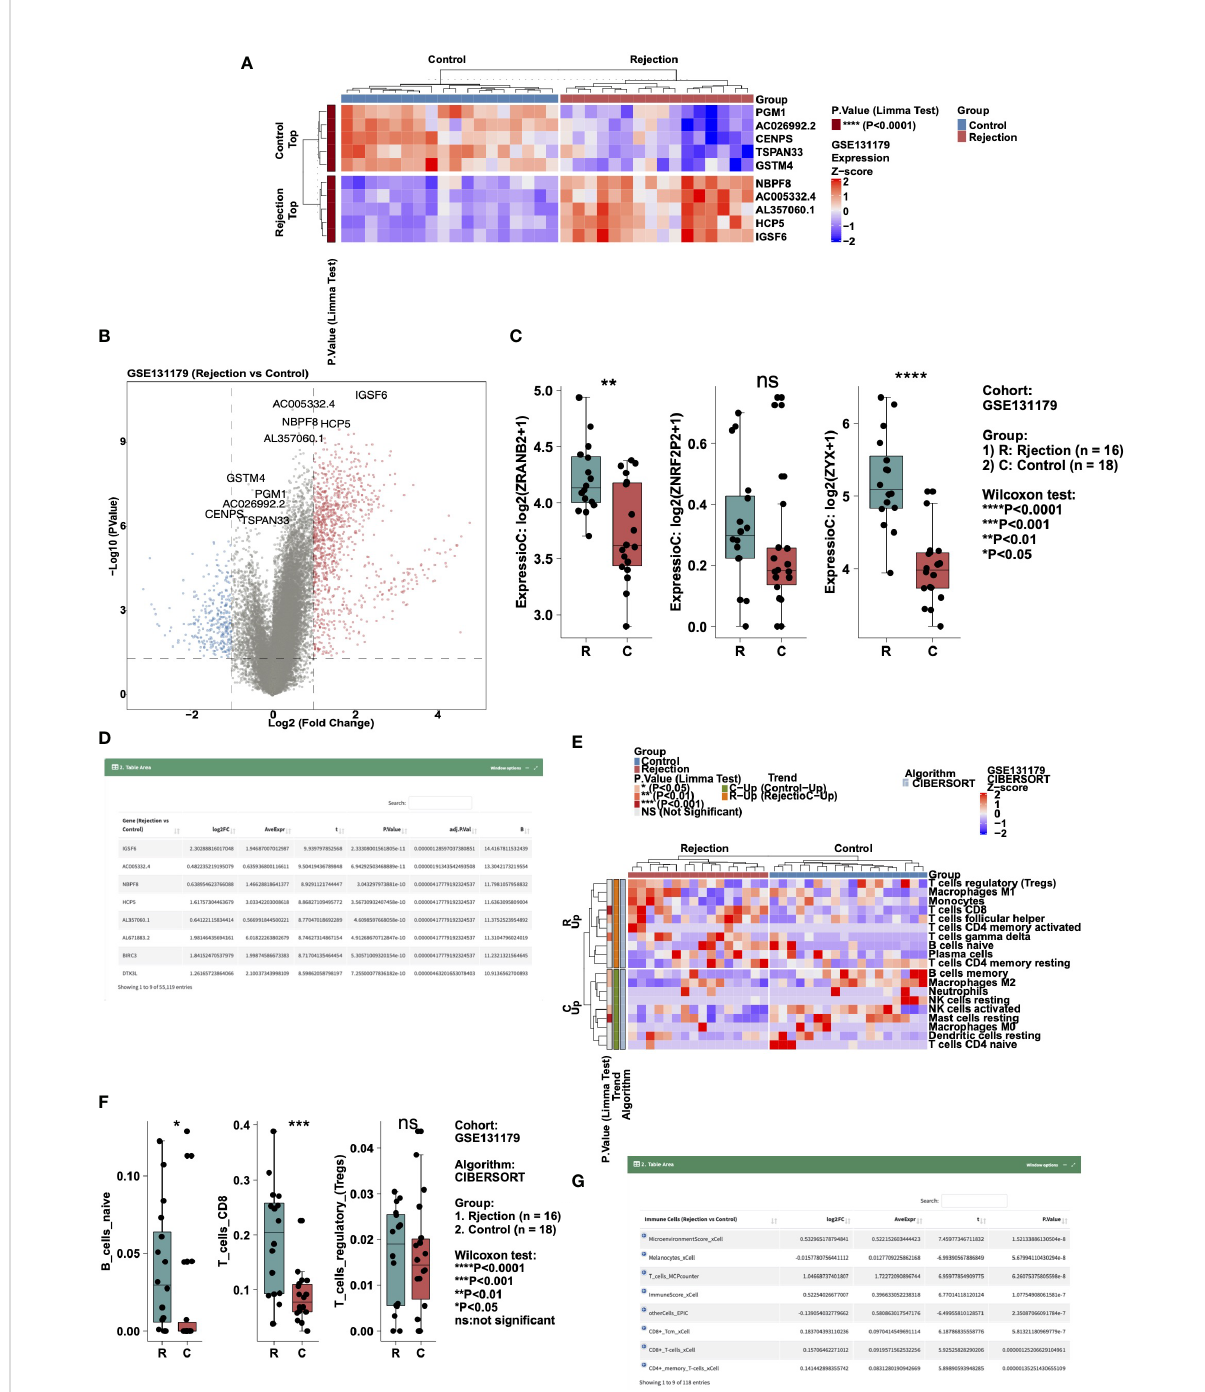
FIGURE 2 Example of the “ Differential Analysis ” tab. (A) Heatmap showing the top5 and down5 gene expression between the rejection and control group in cohort GSE131179. (B) Volcano plot showing the differential expression of genes between the rejection and control group in cohort GSE131179. (C) Boxplot showing the differences in the gene expressions of ZRANB2, ZNRF2P2, and ZYX between the rejection and control group in cohort GSE131179. (D) Data table showing the result of the differential expressing genes analysis. (E) Heatmap showing the immune cell scores estimated by CIBERSORT in the GSE131179 cohort. (F) Boxplot showing the differences in the score of B_cells_naive, T_cells_CD8, and T_cells_regulatory_(Tregs) between the rejection and control group in cohort GSE131179. (G) Data table showing the result of the differential immune cell scores between the rejection and control group in cohort